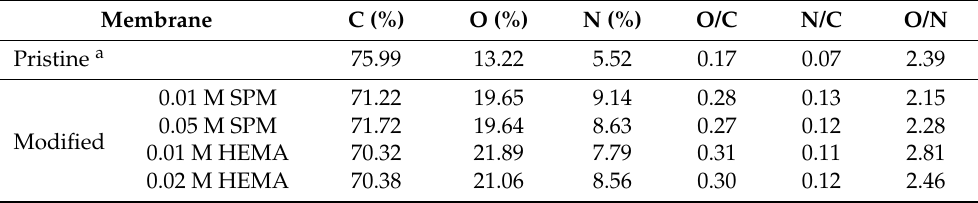
Figure 4. High resolution XPS spectra for modified NF90 using ( a ) 0.01 M SPM, ( b ) 0.05 M SPM, ( c ) 0.01 M HEMA, and ( d ) 0.02 M HEMA. Table 2. Surface atomic concentrations of the pristine and modified NF90.